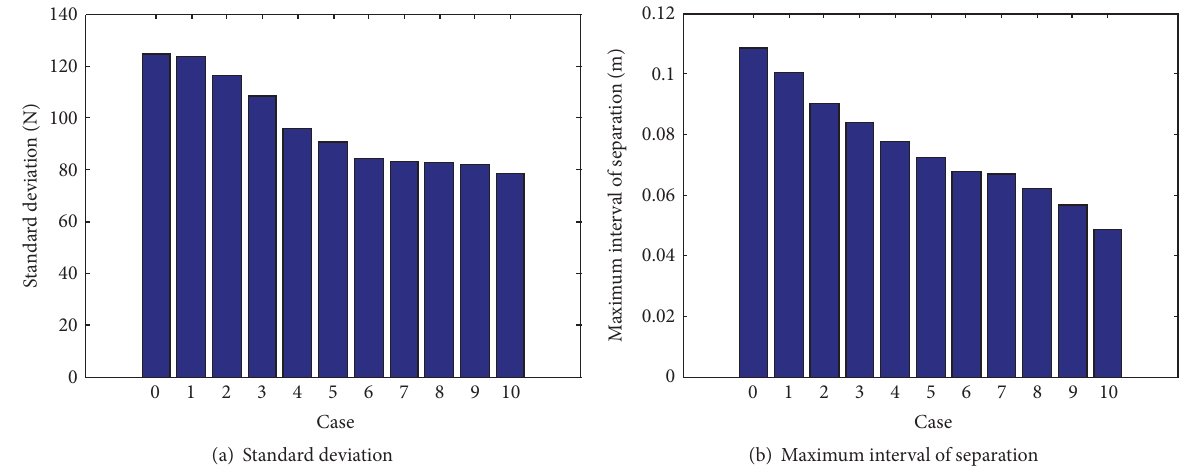
Figure 19: The results of standard deviation of contact force and maximum interval of separation.